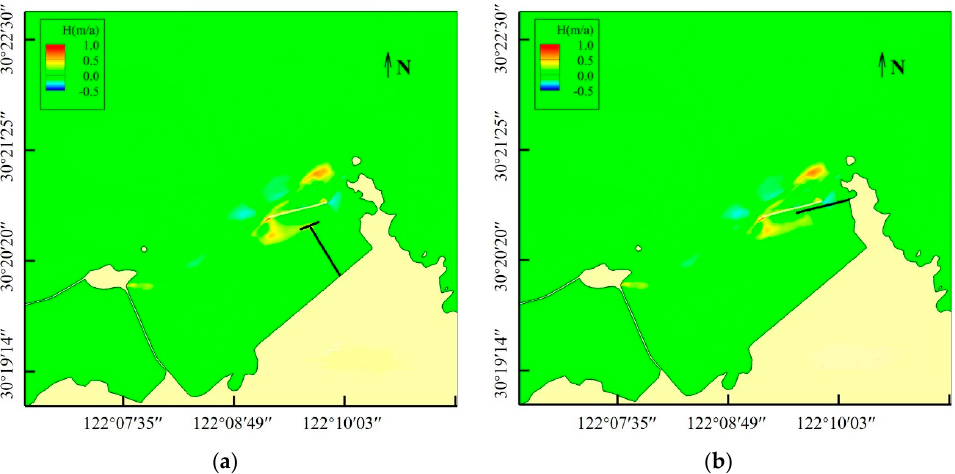
Figure 17. Distribution of siltation intensity before and after different plans’ implementation. ( a ) Plan I, ( b ) Plan II.